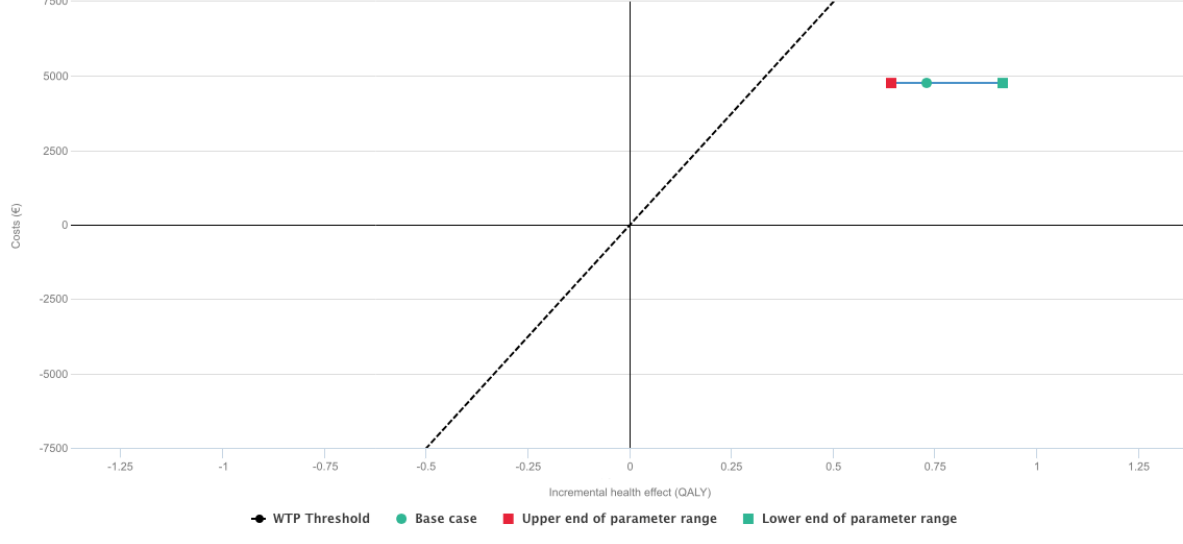
Figure 5. Sensitivity analysis showing effects between 0% and 5% change in costs—willingness-to-pay of €15,000 (approximately